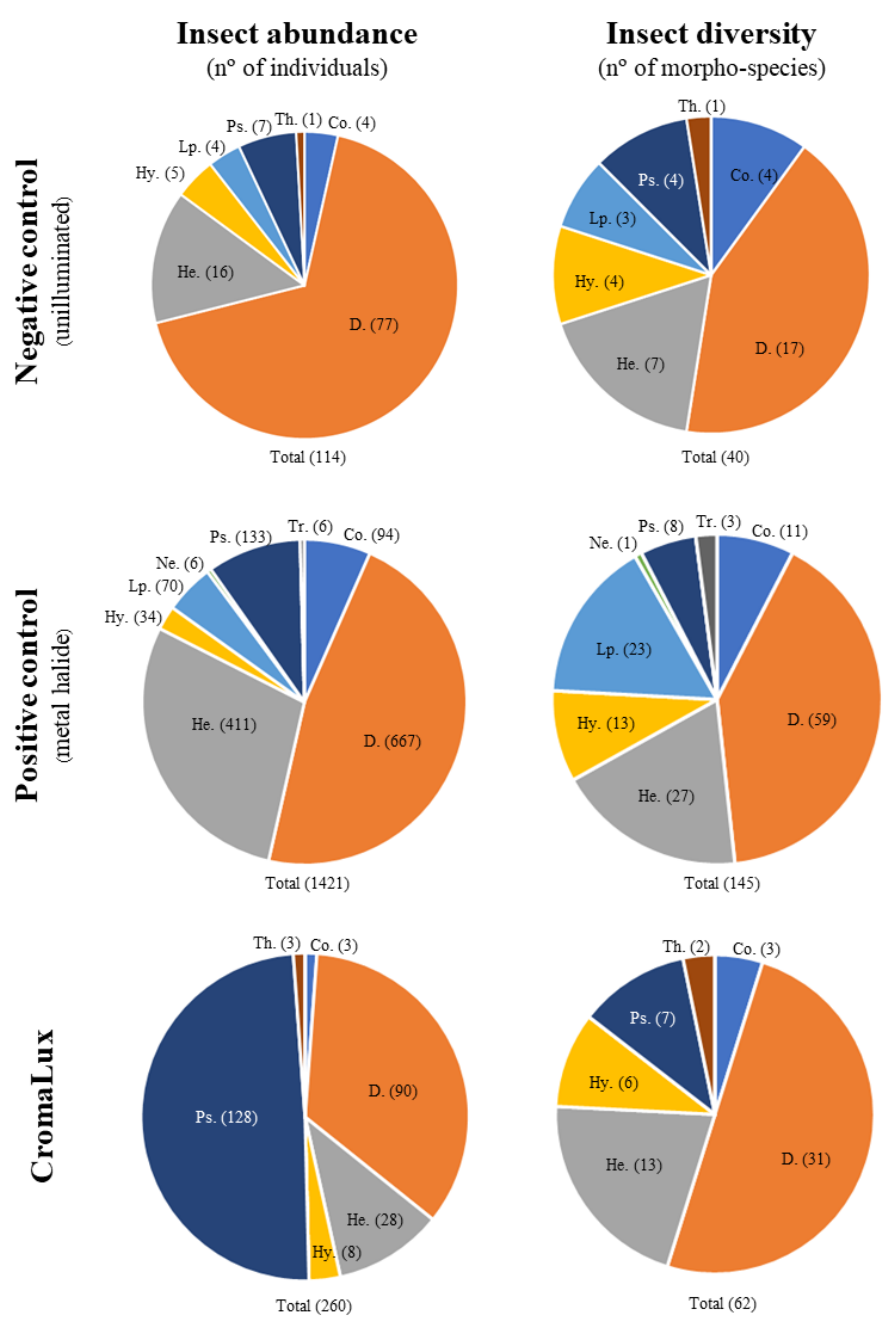
Figure 6. Insect abundance and insect biodiversity captured beside the three lighting systems. Co: Coleoptera, D.: Diptera, He.: Hemiptera, Hy.: Hymenoptera, Lp.: Lepidoptera, Ne.: Neuroptera, Ps.: Psocoptera, Th.: Thysanoptera, Tr.: Trichoptera